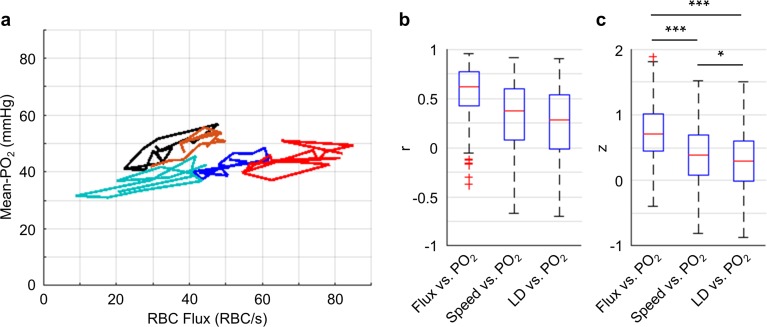
Correlations between the temporal fluctuations of capillary RBC flux, speed, line-density and Mean-PO2.(a) Temporal evolutions (9-s-long traces with 0.6 s steps) of RBC flux and Mean-PO2 from five representative capillaries. For each capillary, its Mean-PO2 as a function of RBC flux is represented by a different line color; the consecutive time points are connected to illustrate the temporal trajectory of the variation. (b) Boxplots of the pairwise correlation coefficients (r) between the temporal fluctuations of capillary RBC flux, speed, line-density (LD) and Mean-PO2. (c) Boxplots of the Fisher z values calculated based on the r values in b. The analysis in b and c was made with 373 capillaries, collected in cortical layers I-V, across n = 7 mice. Statistical comparisons were carried out using ANOVA followed by Tukey HSD post hoc test. The single-asterisk symbol (*) indicates p<0.05; the triple-asterisk symbol (***) indicates p<0.0001.